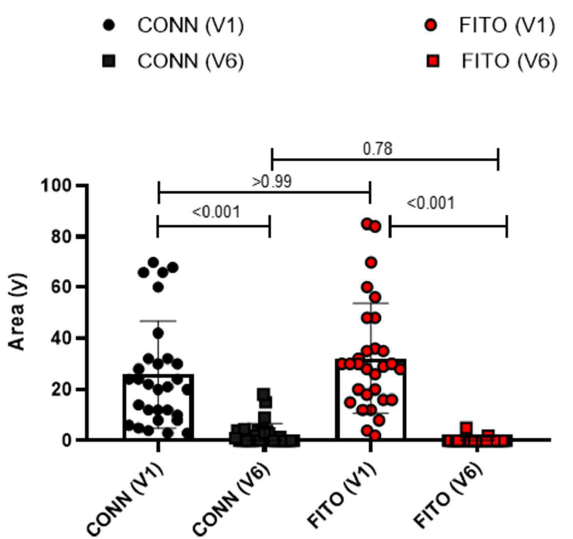
Figure 2. Effectiveness of treatment protocols. Conn(v1), wound area in patients treated with Connettivina ® Bio Plus in V1; Conn (V6), wound area in patients treated with Connettivina ® Bio Plus in V6; Fito(v1), wound area in patients treated with Fitostimoline ® Plus in V1; Fito (V6), wound area in patients treated with Fitostimoline ® Plus in V6. Total wound healing was achieved in 17 patients undergoing treatment with Con- nettivina ® Bio Plus, and in 28 patients undergoing treatment with Fitostimoline ® Plus. The greater effectiveness of Fitostimoline ® Plus was significant ( p = 0.001, risk ratio 0.15 (95% CI 0.04 to 0.62)). The reduction in the wound area was assessed. The wound healing rate was greater in Group B; however, these data were not statistically significant. A reduction in fibrin and maceration of the wound edges was observed in both treatment groups; however, Group B showed more satisfying results regarding reduction of fibrin on the wound bed ( p = 0.04, risk ratio 0.2 (95% CI 0.02 to 1.70)) (Table 4) (Figures 3 and 4). Table 4. Treatment and outcomes. Outcome